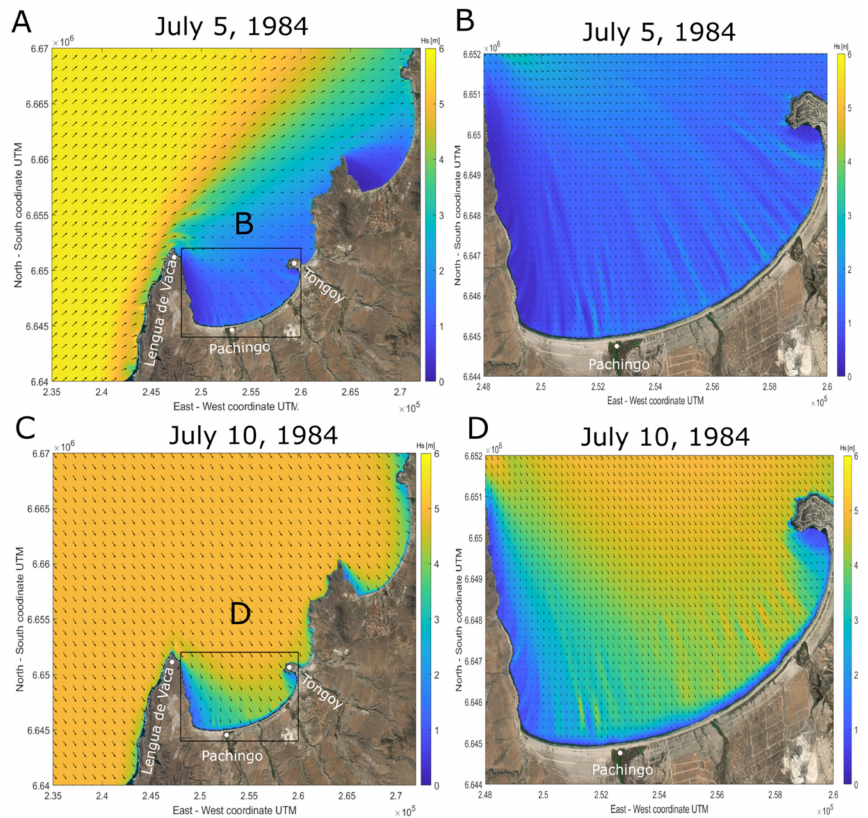
Figure 8. SWAN model propagation for mid-resolution mesh 100 × 100 ( A , C ) and SWAN model propagation for high-resolution mesh 20 × 20 ( B , D ). Hs: indicates the wave height in m. Black square indicates the zoom area for images on the left side ( B , C